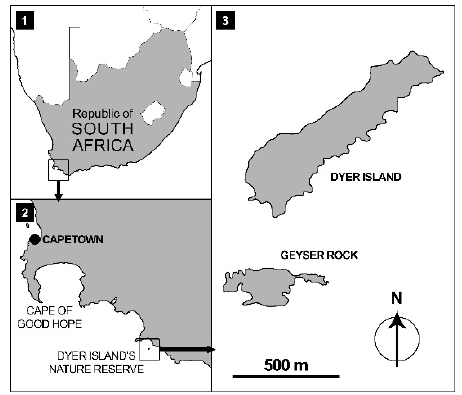
Figure 1. Dyer Island and Geyser Rock Nature Reserve.